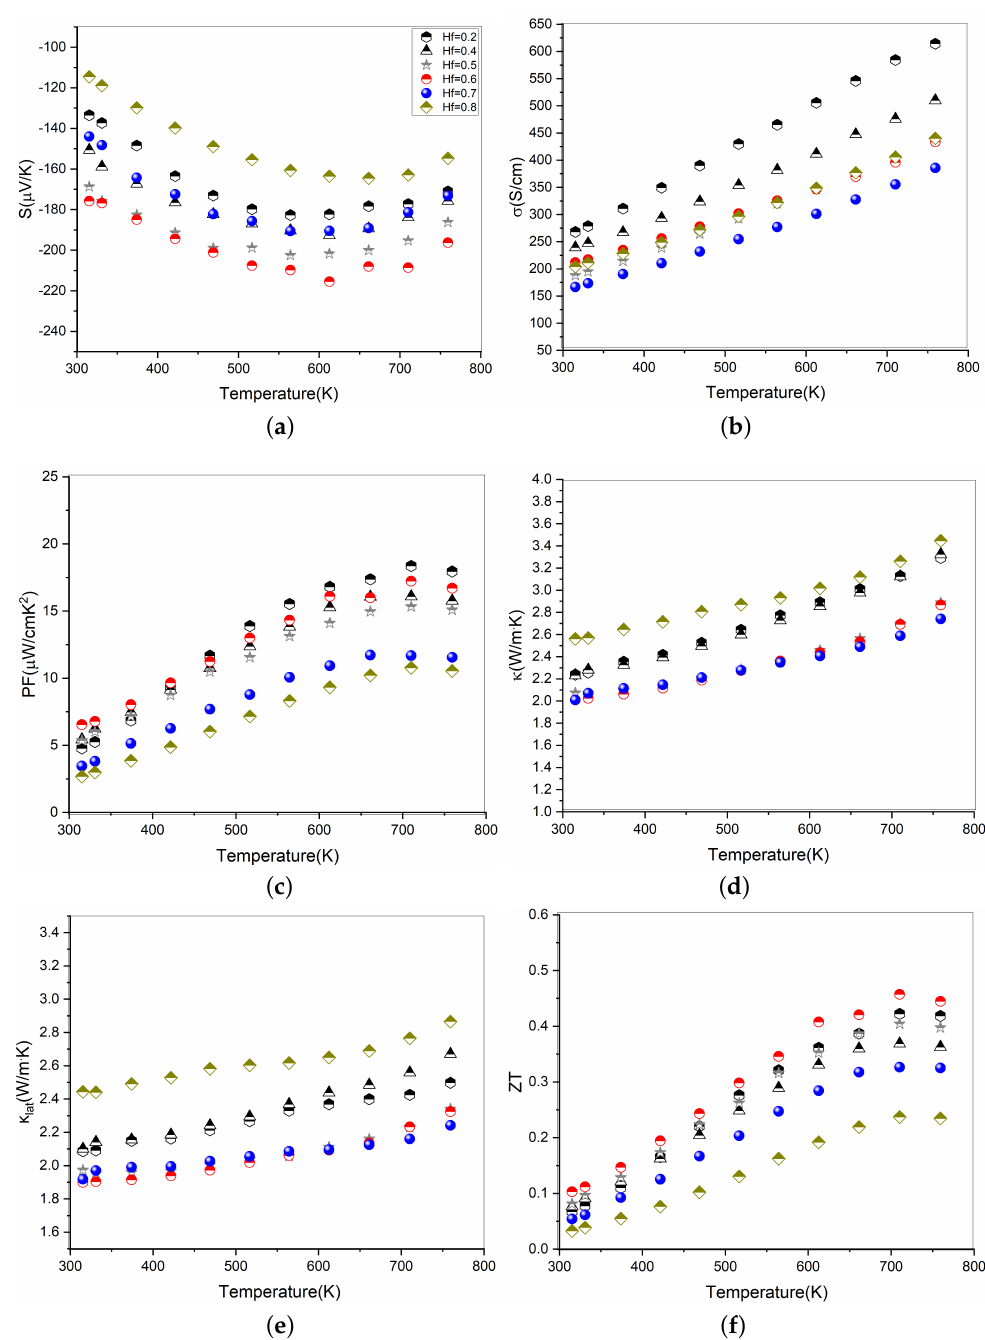
Figure 6. ( a ) Seebeck Coefficient, ( b ) Electrical conductivity, ( c ) Power factor, ( d ) Thermal conductivity, ( e ) Lattice thermal conductivity, and ( f ) Figure of merit of the Ti 1 − x Hf x NiSn